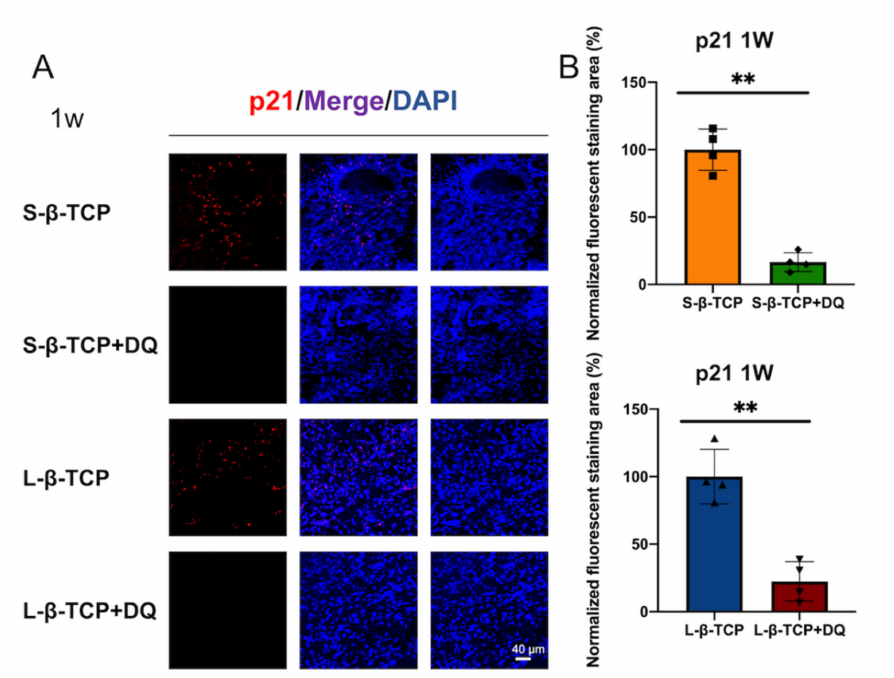
Figure 7. Identification of cellular senescence in bone defects one week after the operation. ( A ) Im- munofluorescent images stained with p21 antibody and DAPI (scale bar = 40 µ m); ( B ) p21 quantified protein level at ROI in bone defect normalized against samples without DQ. The ratio of positive area for groups without DQ administration was one hundred percent. Mean with SD ( n = 4). ** p < 0.01: Student’s t -test. D: Dasatinib; Q: Quercetin.